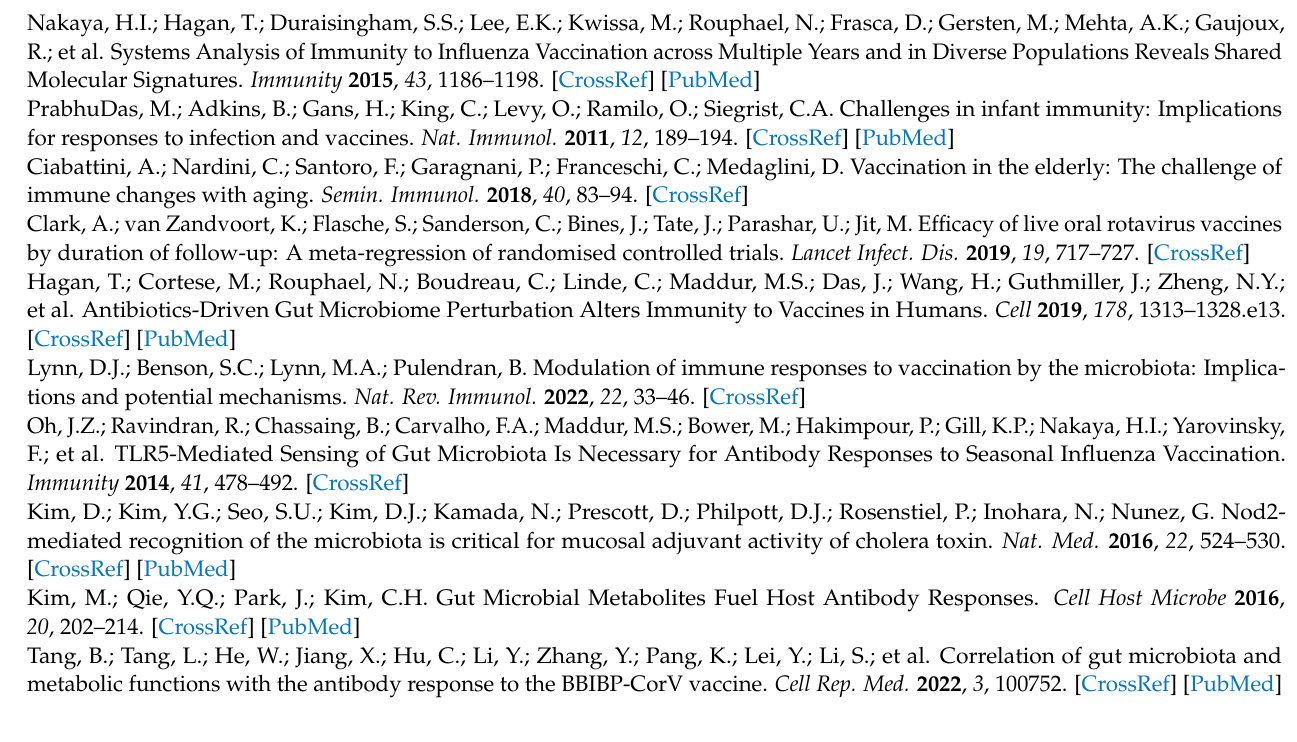
Figure S2: The abundance of Firmicutes and Bacteroidota in the control and jujube groups; Table S1: Relevant statistics depend on the statistical